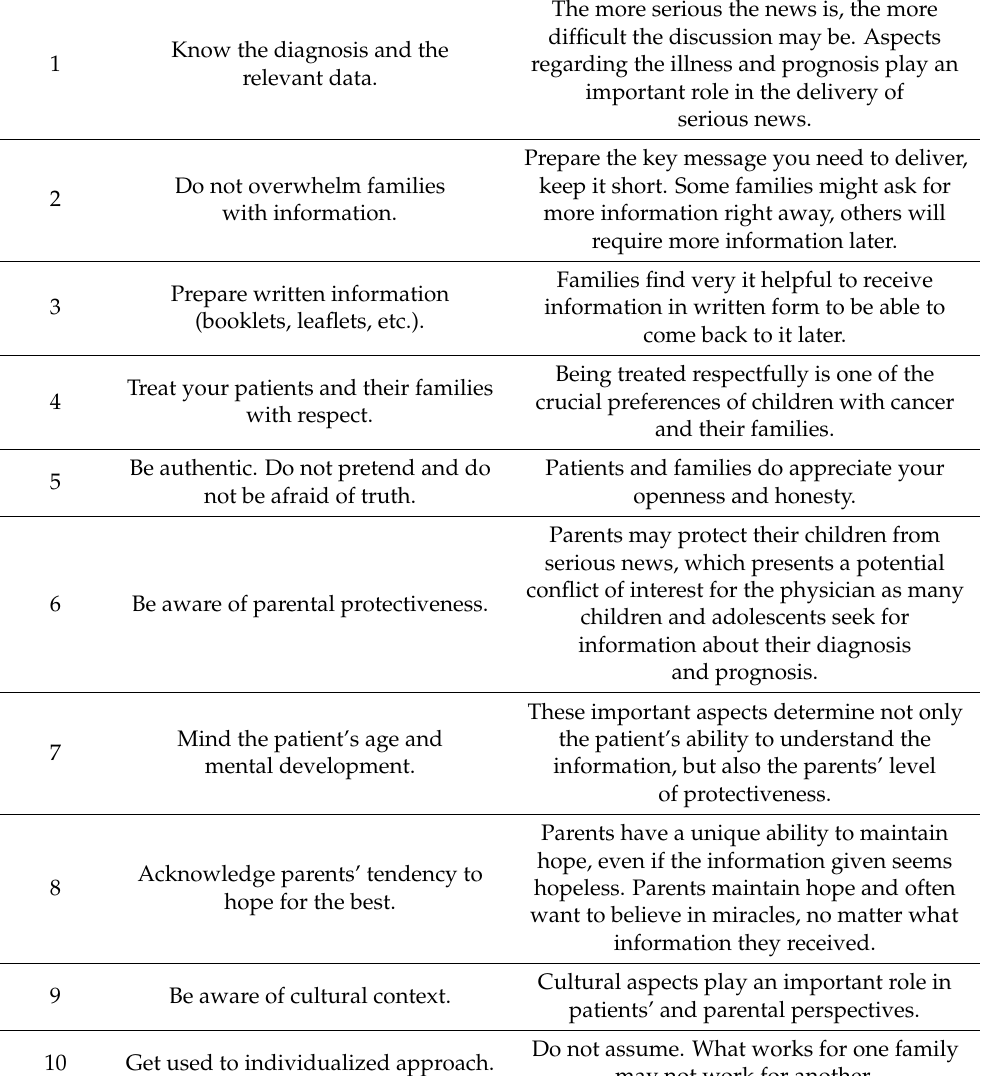
Table 3. Ten key